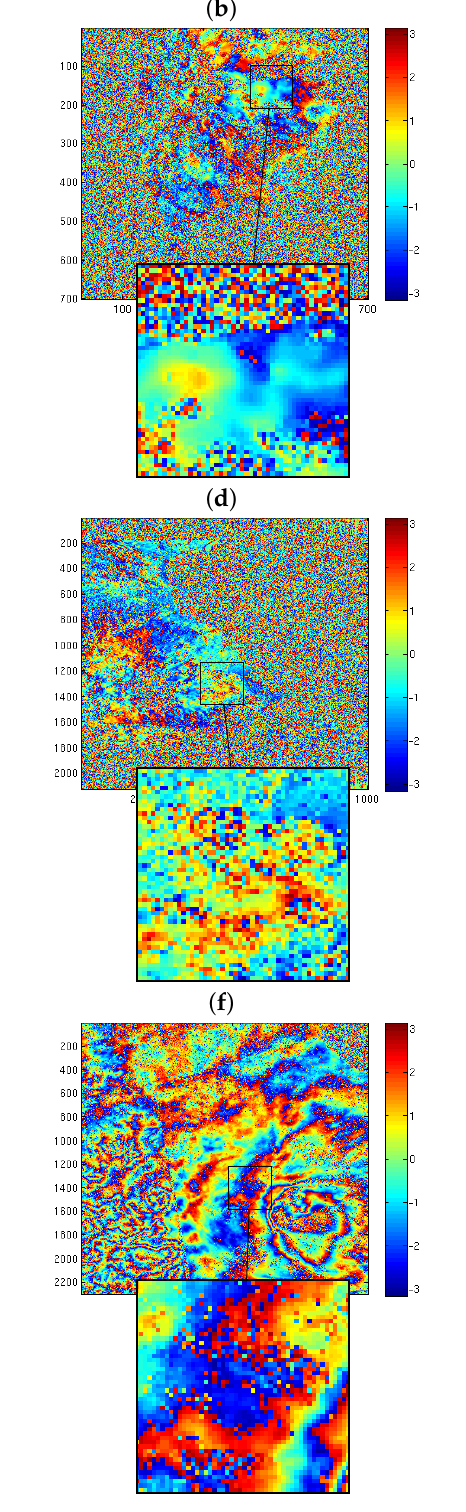
Figure 16. ProK-SVD denoised interferograms of several SAR sensors over the area of the Etna Volcano (Italy). ( a ) ERS original interferogram, and zoomed view; ( b ) ERS denoised interferogram, and zoomed view; ( c ) ALOS original interferogram, and zoomed view; ( d ) ALOS denoised interferogram, and zoomed view; ( e ) COSMO-SkyMed original interferogram, and zoomed view; ( f ) COSMO-SkyMed denoised interferogram, and zoomed